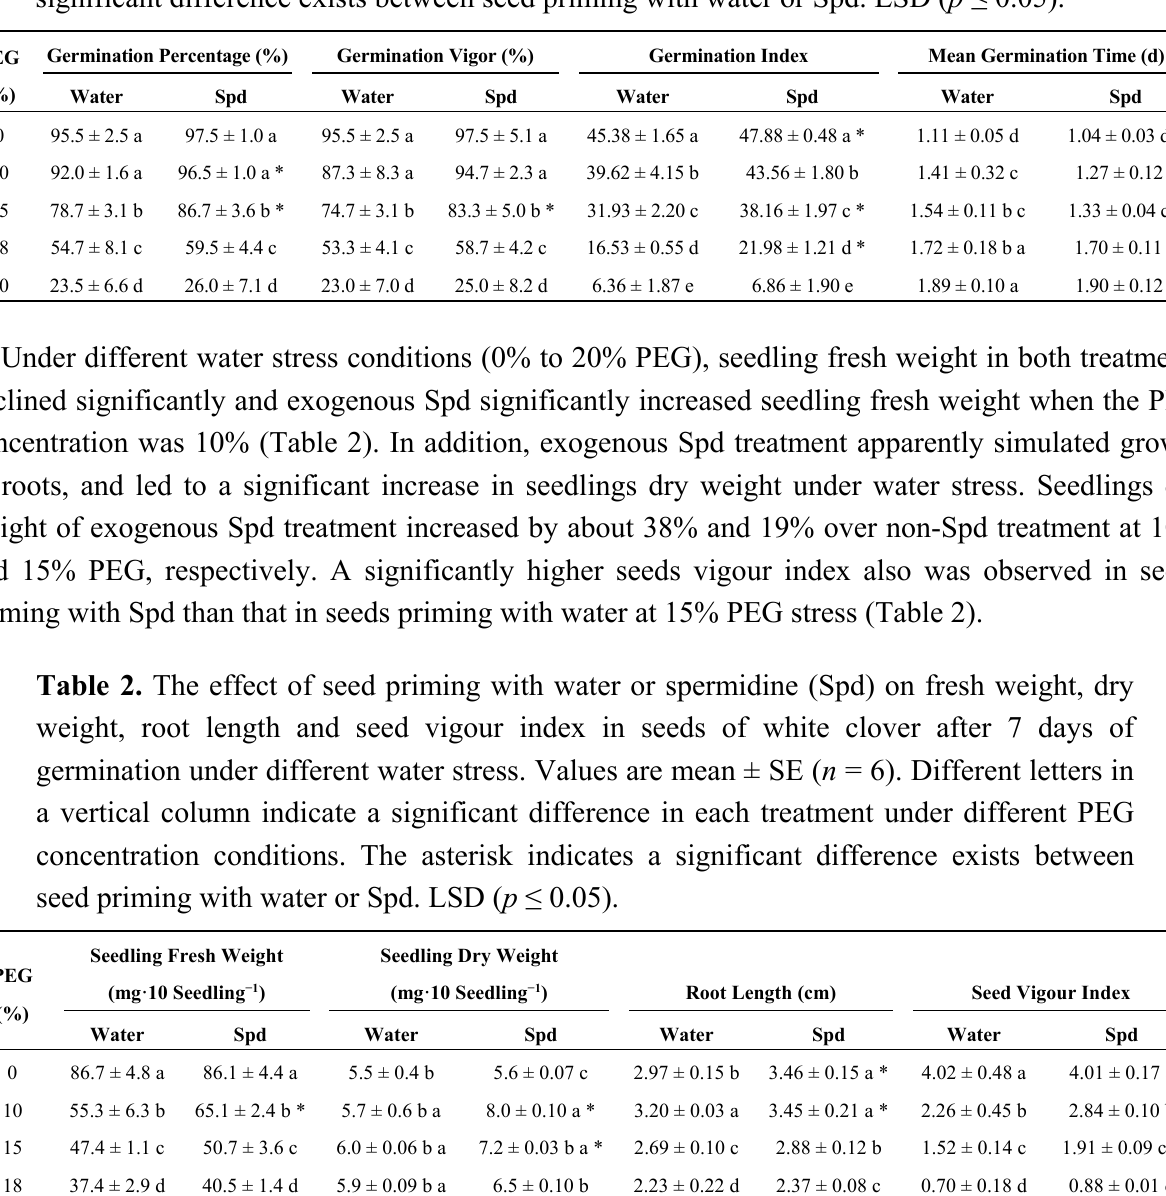
Table 1. The effect of seed priming with water or spermidine (Spd) on seed germination characteristics in white clover under 7 days of different water stress conditions. Values are mean ± SE ( n = 6). Different letters in a vertical column indicate a significant difference between each treatment under different PEG concentration. The asterisk indicates a significant difference exists between seed priming with water or Spd. LSD ( p ≤ 0.05).